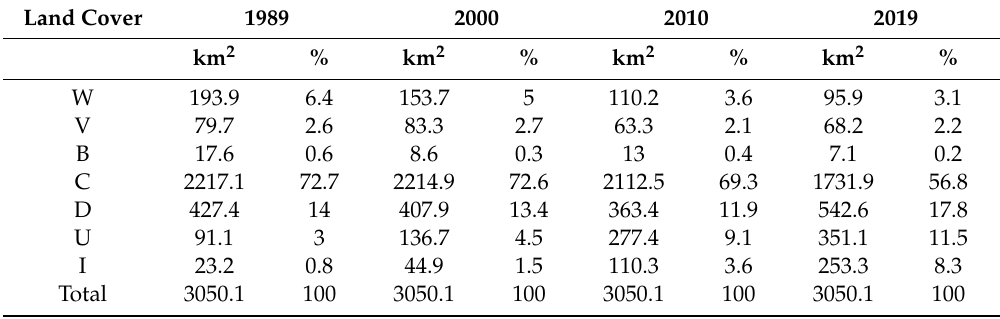
Table 5. LULC changes (as percentages) in the study area between 1989 and 2019. Land Cover